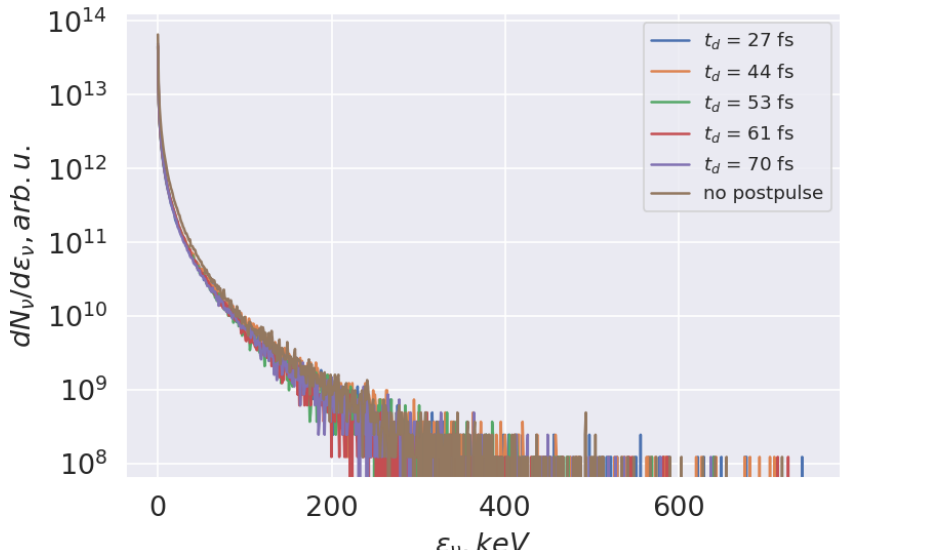
Figure 8. Comparison of photon spectra obtained from the simulations for 11 fs laser pulses with 5 fs postpulses following the main pulse at different delays. In all simulations the main pulse amplitude was a 0 = 6.5 and the postpulse amplitude was a 0 = 3.6 except the case without postpulse shown for reference in which the main pulse amplitude was a 0 = 7.5.